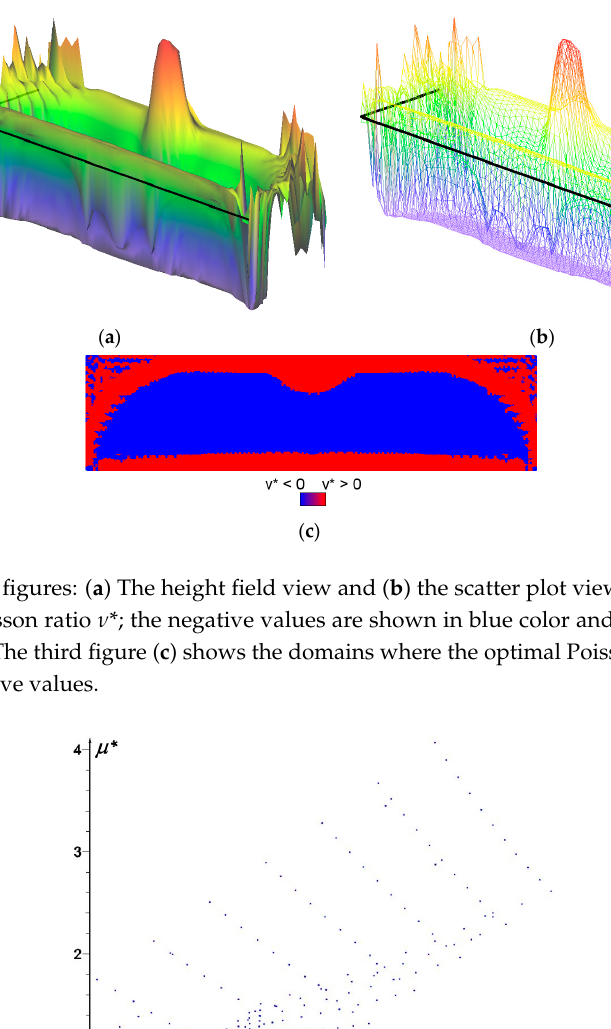
Figure 4. Distribution of optimal pairs of points ( k *, μ *).